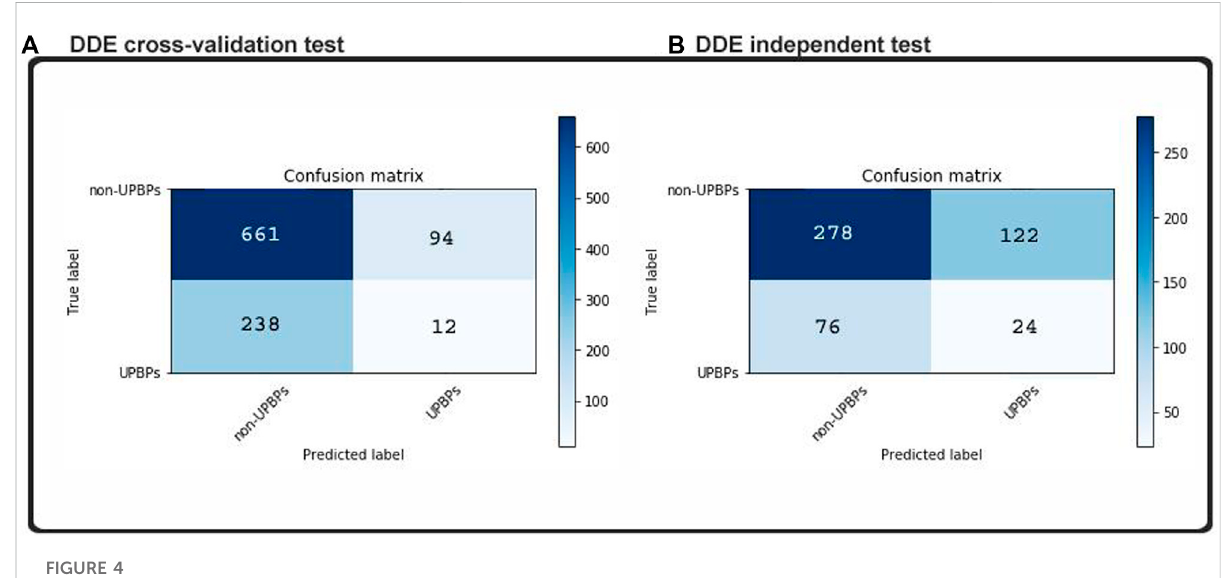
FIGURE 4 Confusion matrices predicted labels based on (A) cross-validation test and (B) independent